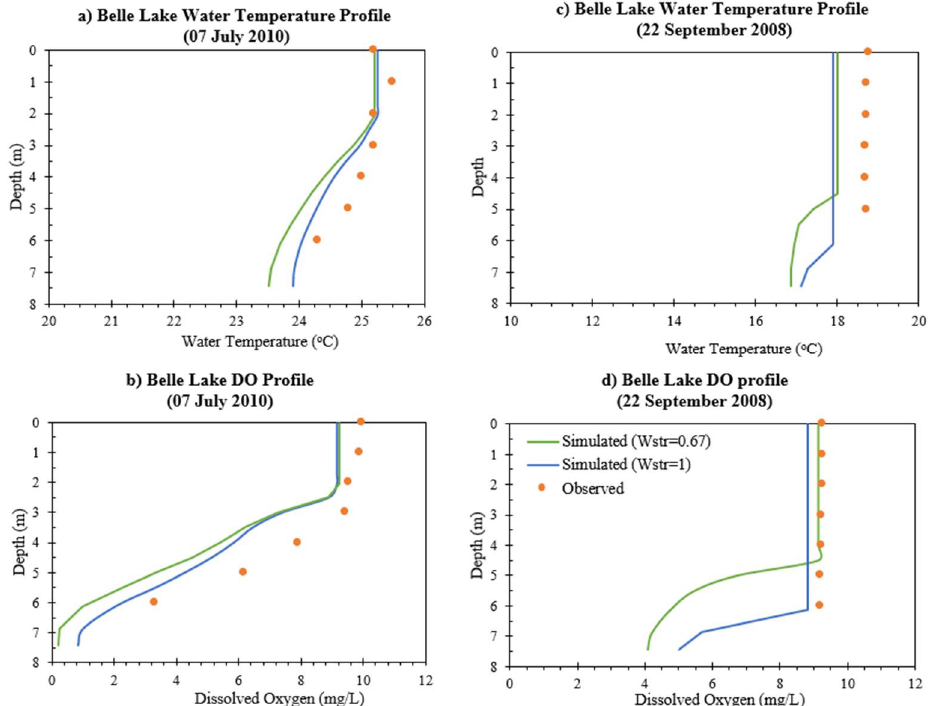
Figure 1. Effect of wind sheltering coefficient (increasing from 0.67 to 1) on simulated ( a ) water temperature and ( b ) dissolved oxygen profiles on 7 July 2010; ( c ) water temperature and ( d ) dissolved oxygen profiles on 22 September 2008 in Belle Lake including observed profiles. Table 4. Statistical error parameters for the hourly and daily MINLAKE models against observed profile data in five study lakes.